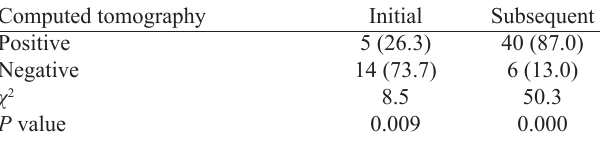
Table 4. Results of computed tomography and time of scanning, n